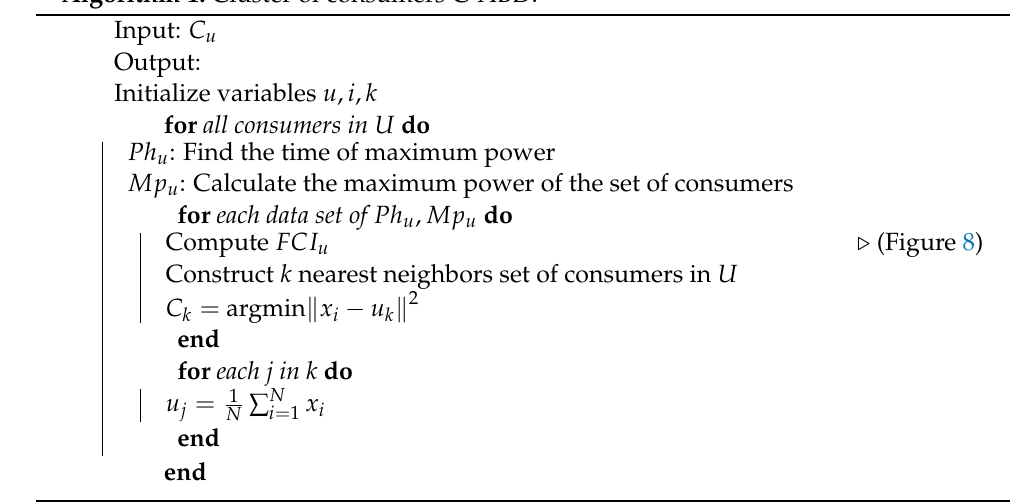
Algorithm 1: Cluster of consumers